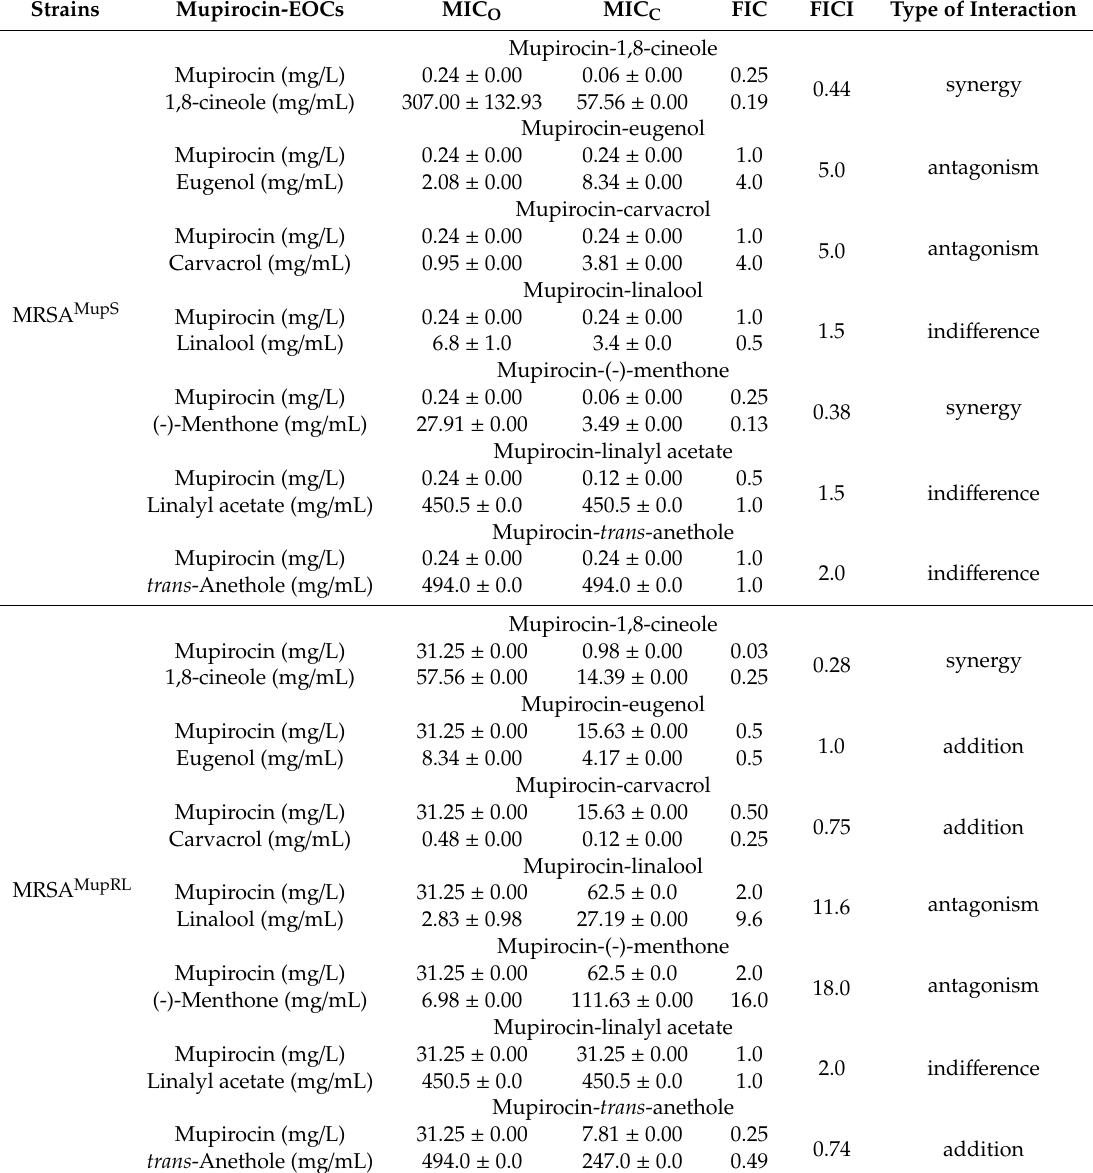
Table 1. Fractional inhibitory concentration (FIC) and FIC indices (FICI) of mupirocin-essential oil compound (EOC) pairs against mupirocin-susceptible (MRSA MupS ) and induced low-level mupirocin-resistant (MRSA MupRL )